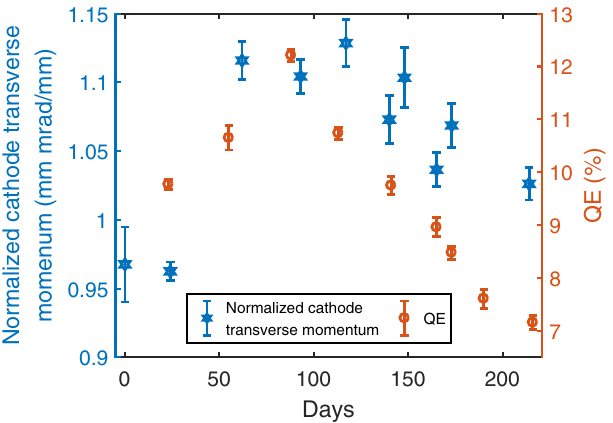
FIG. 15. The evolution of thermal emittance and QE for the Cs 2 Te photocathode #661.1 in the PITZ beam line. The blue data points refer to the normalized cathode transverse momentum and the corresponding vertical axis is on the left. The red data points refer to the QE and the corresponding vertical axis is on the right. The emission field at MMMG phase is roughly 40 MV = m for the measurements and the laser wavelength is 257